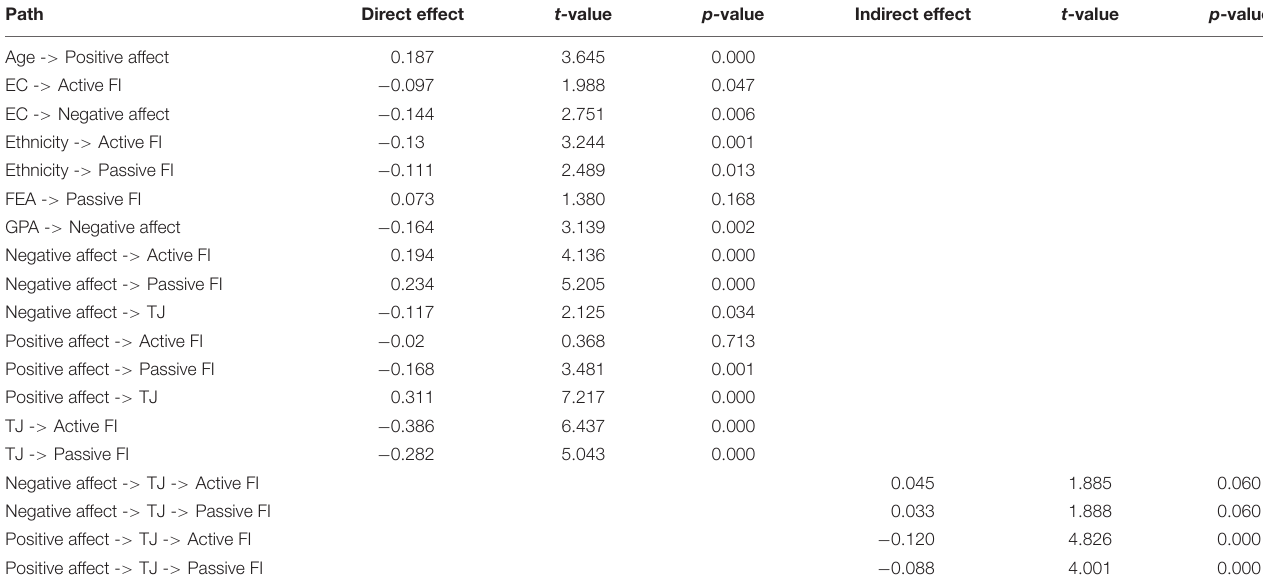
TABLE 4 | Significance analysis of the direct and indirect